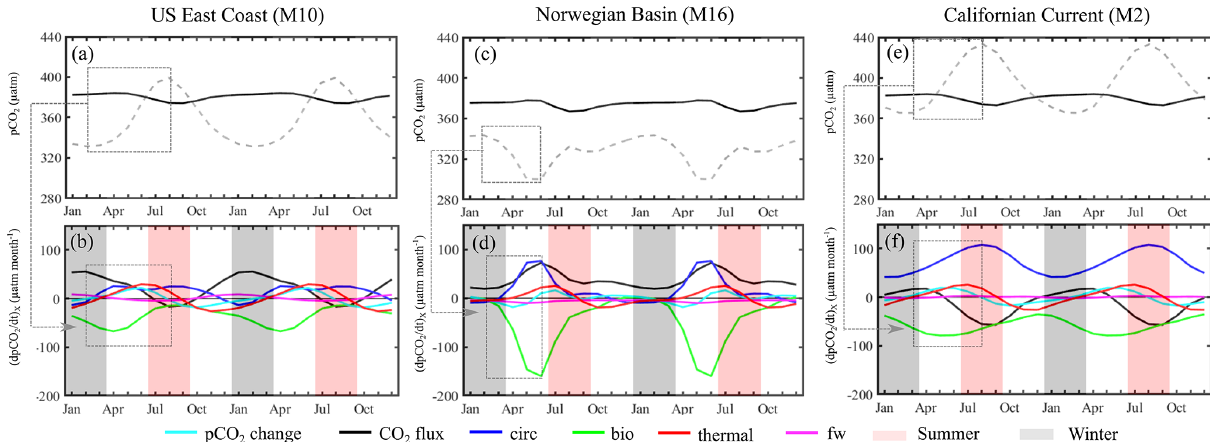
Figure 7. Processes controlling the ocean p CO 2 seasonal cycle. Mean seasonal sea surface p CO 2 (dashed line) and atmospheric p CO 2 (black line; inµatm) simulated by MOM6-COBALT and detrended over (a) the US East Coast (M10), (c) the Norwegian sea (M16) and (e) the Californian current (M2). Spatially averaged contributions (inµatmmonth − 1 ) from biological activity (bio, green), temperature changes (thermal, red), transport of chemical species (circ, blue), freshwater flux (fw, pink) and the CO 2 air–sea flux (CO 2 flux, black) controlling the p CO 2 temporal change ( p CO 2 change, cyan) for the three regions ( b , d , f ). A positive value corresponds to an increase in sea surface p CO 2 . Winter corresponds to the months of January, February and March, and summer corresponds to the months of July, August and